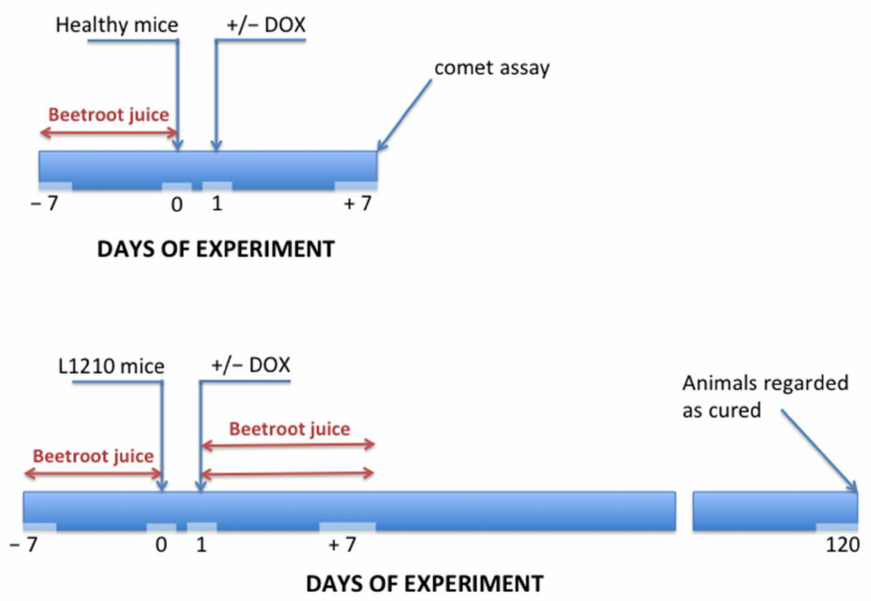
Figure 3. Experimental schemes for assessment of cardioprotective properties of beetroot tested in leukemia-bearing mice treated with